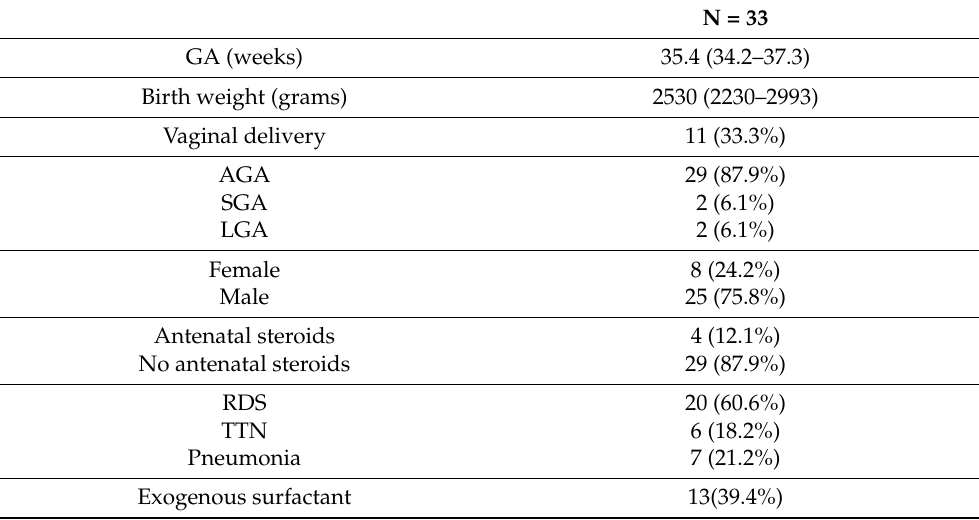
Table 1. Study population details.